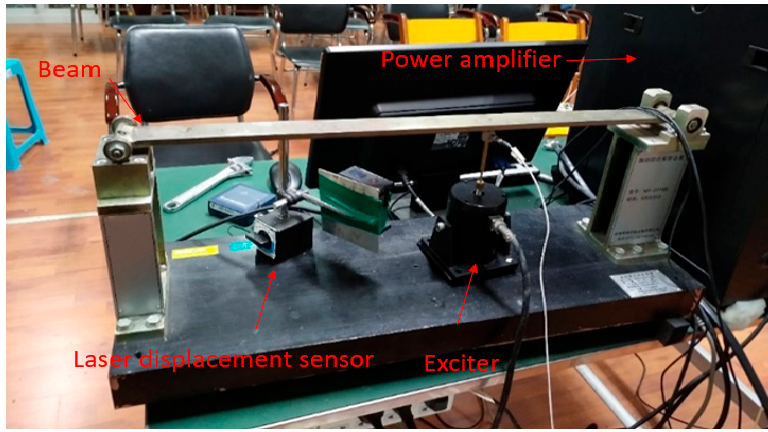
Figure 29. The load identification experiment site. Table 7. Force identification experiment equipment.